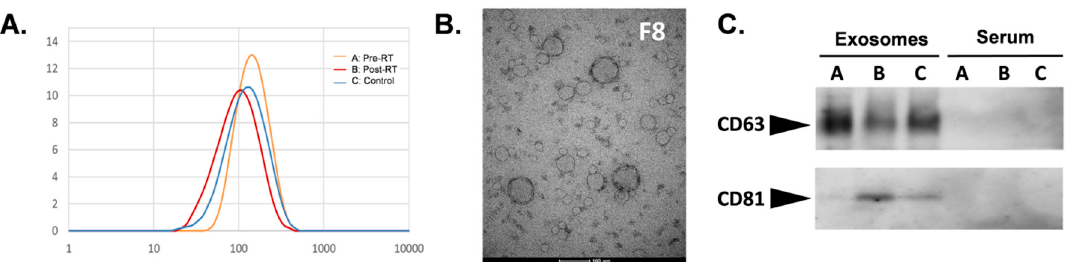
Figure 1. Characterization of serum-derived exosomes. Analysis of the size of vesicles in the size exclusion chromatography (SEC) fraction #8 by the dynamic light scattering ( A ) and transmission electron microscopy ( B ). ( C ) Western blot analysis of CD63 and CD81 in whole serum and serum-derived exosomes (fraction #8) for the three groups of samples ( A : pre-radiotherapy (RT), B : post-RT, C : control).